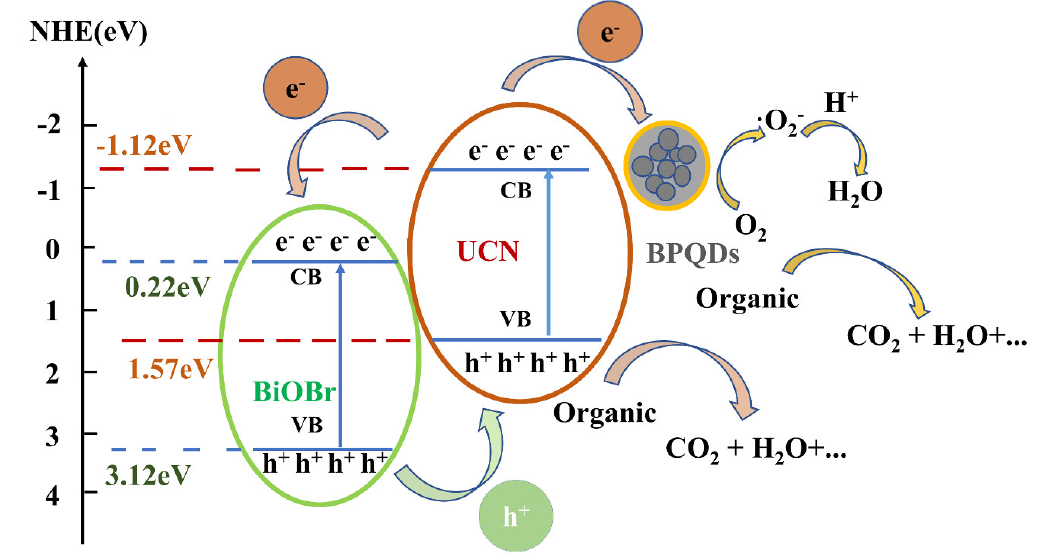
Figure 12. The band structure diagram of tetracycline degradation and possible mechanisms.